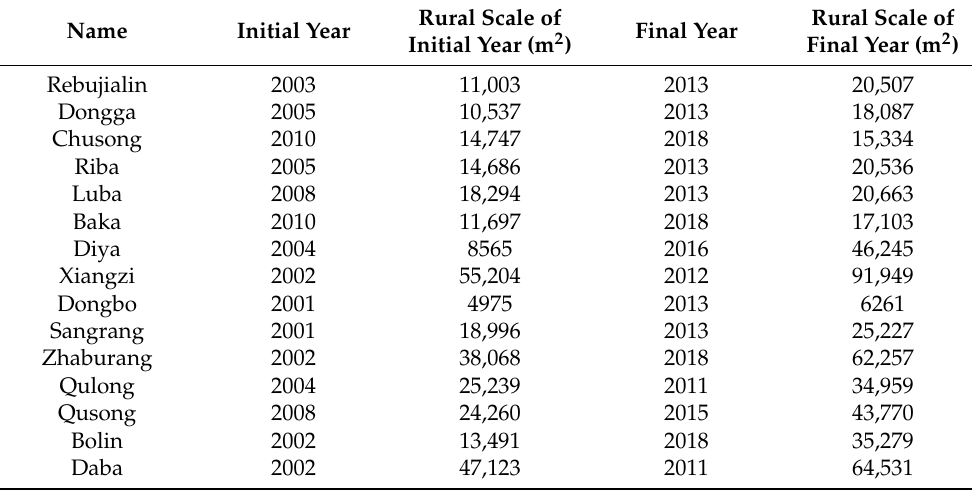
Table 1. The image year and rural scale of 15 rural settlements.